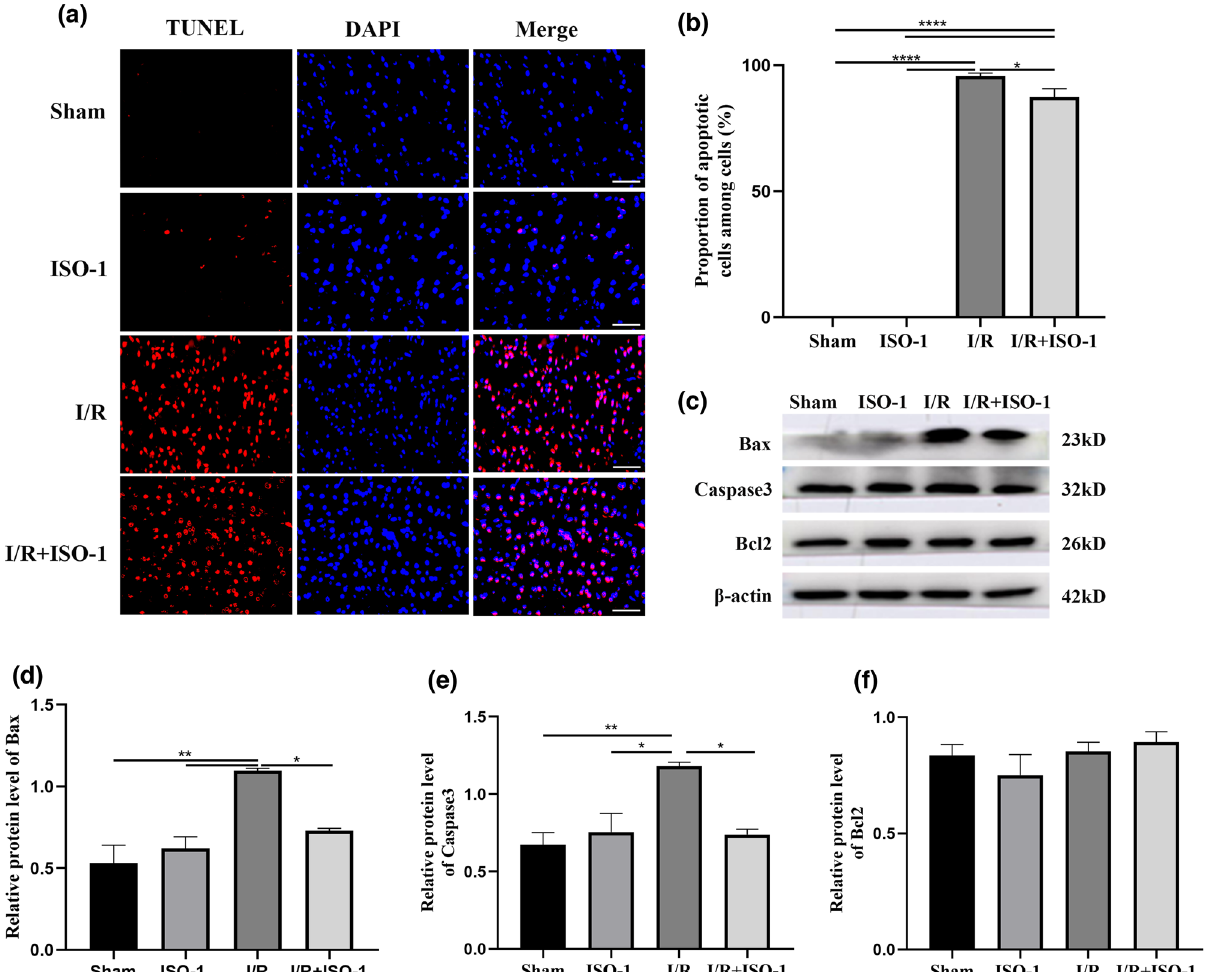
Figure 5. TUNEL staining analysis of apoptotic cells as well as the detection of apoptotic proteins. ( a ) Apoptotic cells were labeled with fluorescein isothiocyanate (red), and all nuclei were stained with DAPI (blue). Bar 50 μm. ( b ) Proportion of apoptotic cells in total cells. ( c – f ) Expression levels of Bax, caspase3, and Bcl2 protein were determined by Western blotting. * P < 0.05, ** P < 0.01, *** P < 0.001, **** P <